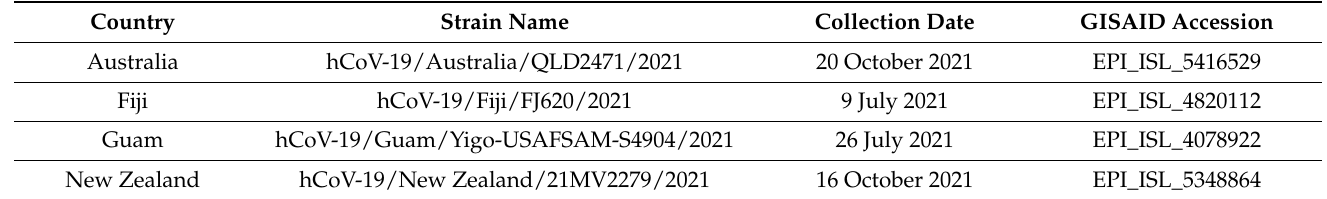
Table 6. Most recent reported occurrences in different countries on the Oceania continent according